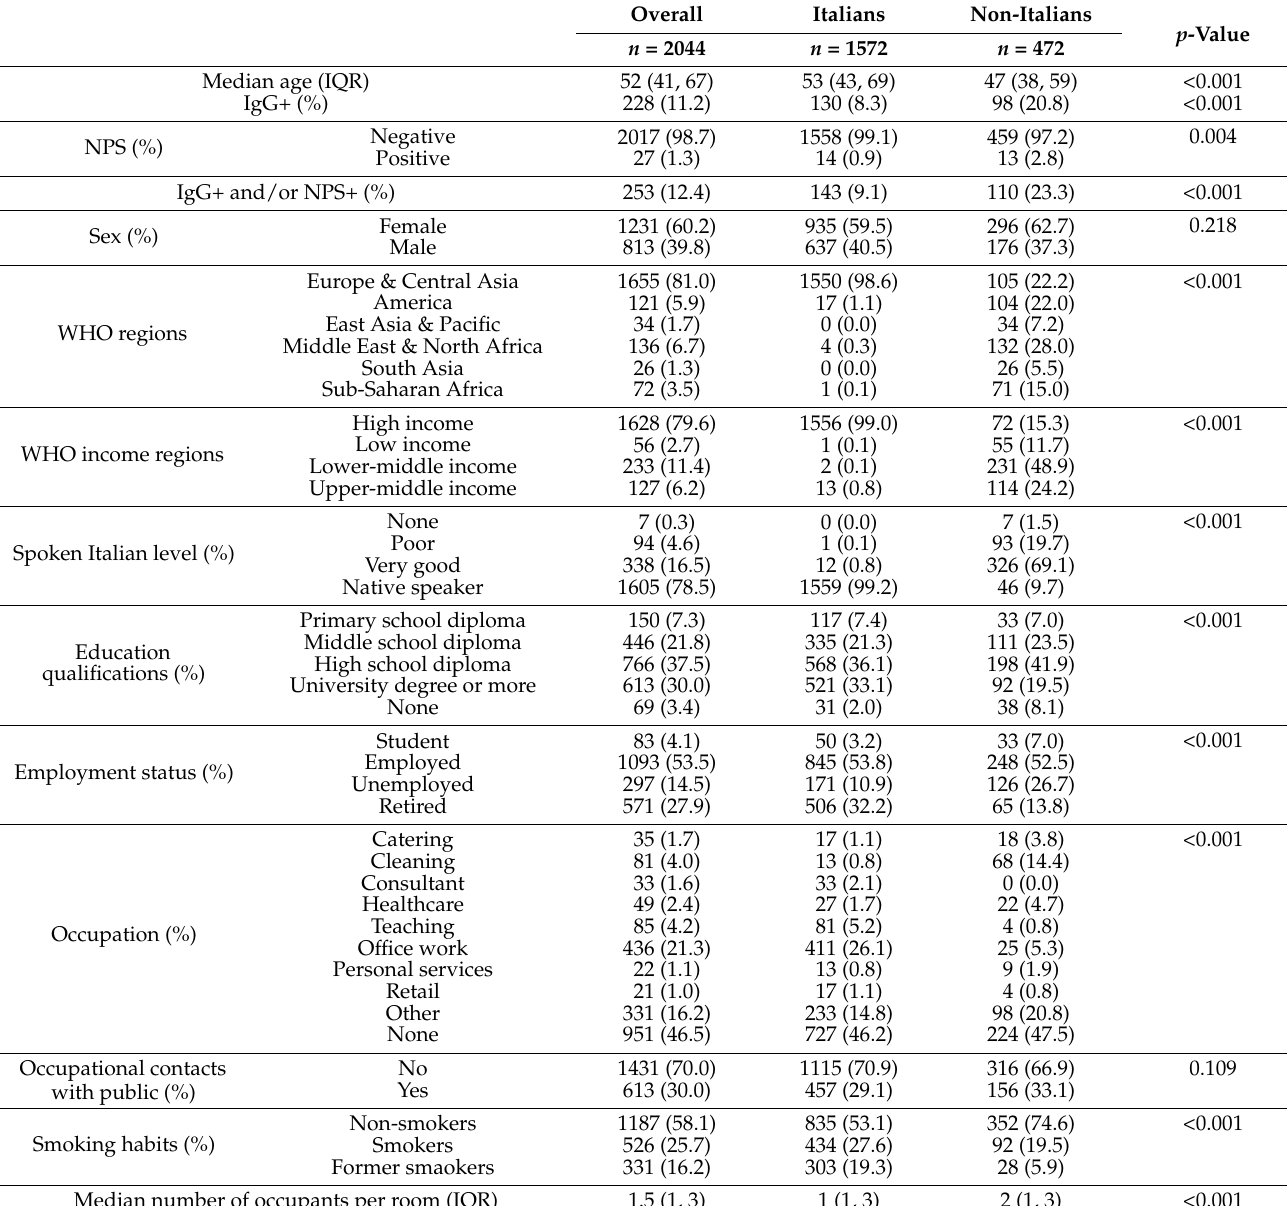
Table 1. Demographic and socio-economic characteristics of the study